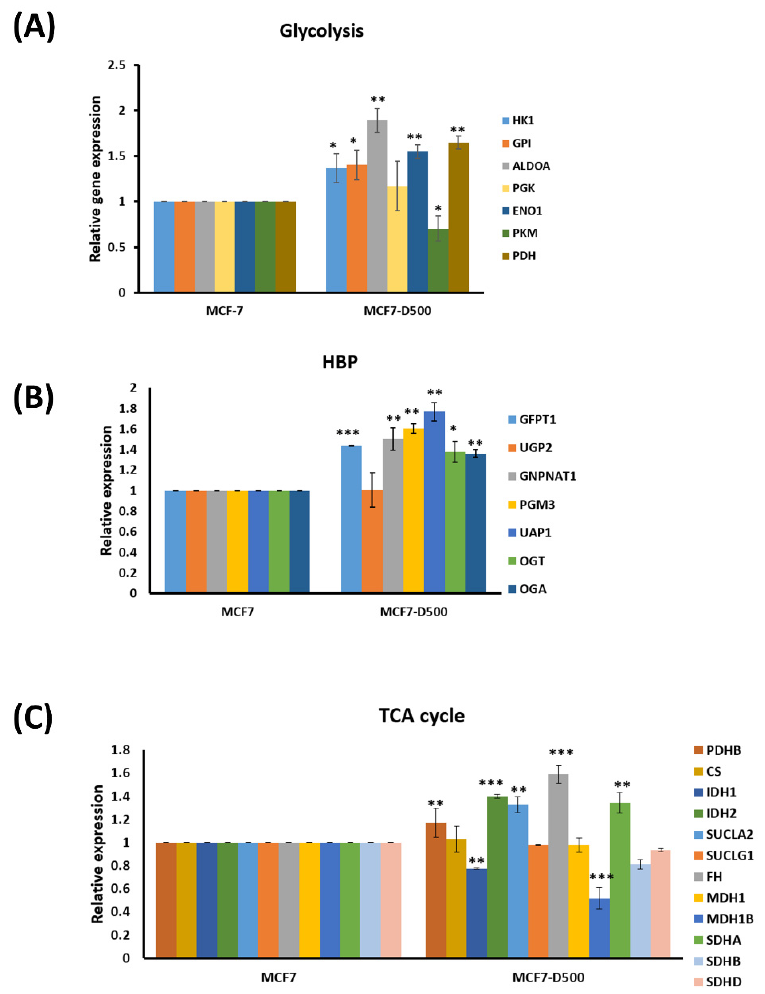
Figure 5. Expression levels of metabolic enzymes were examined in MCF-7 and MCF-7-D500 cells through real-time PCR: ( A ) Glycolysis-related genes; ( B ) HBP-related genes, and ( C ) TCA cycle-related genes. All real-time PCR experiments were performed in triplicate (* p < 0.05; ** p < 0.01, *** p <